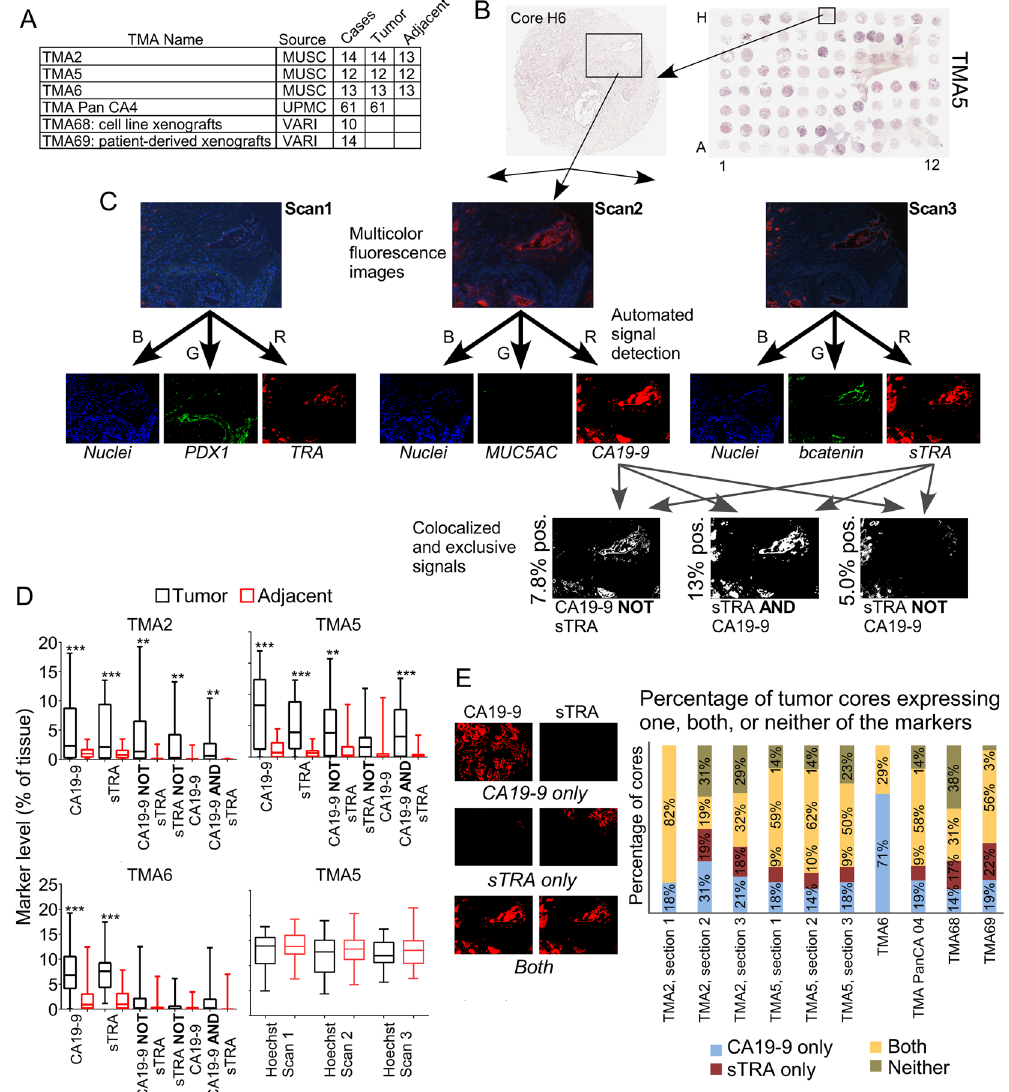
Figure 2. Quantifying signals in tissue microarrays. ( A ) We used six TMAs from three sources. Four TMAs contained primary tumor and adjacent tissue, and two contained tumors from xenografts. ( B ) We collected images that were tiled across the TMA. Each image captured a portion of a core, as represented by the box. ( C ) We separately analyzed the blue, green, and red channels from each of the three rounds of immunofluorescence, resulting in nine images per region. The first step was to locate the signals in each image. Next we quantified the amount of signal in each individual image as well as the amount of exclusive or colocalized signal among various combinations of images. ( D ) We compared each of the quantified signals between the tumor cores and the adjacent tissue cores. The amount of signal from the nuclei (stained by Hoechst 33258) was equivalent between tumor and adjacent tissue in all comparisons. ( E ) We quantified the occurrences of tumor tissue that contains one, both, or neither of the markers in each of the TMAs. The images provide examples of each